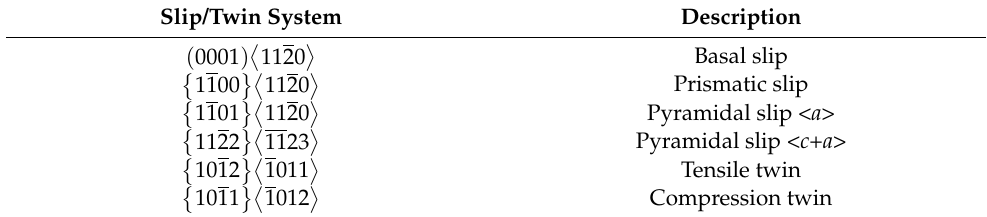
Table 2. Representative slip/twin systems for zinc [22].